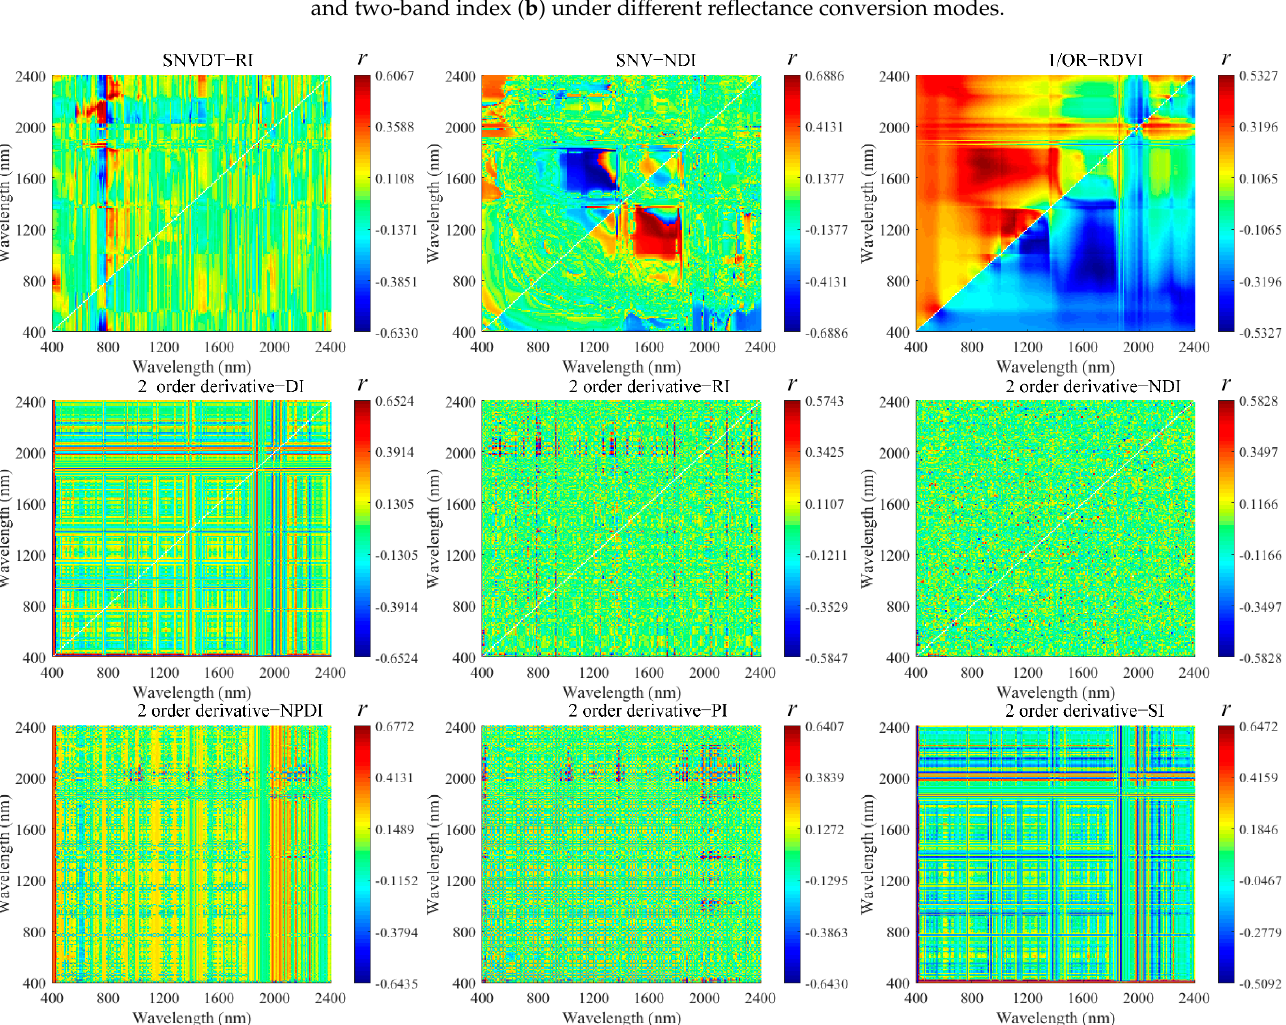
Figure 6. Two-dimensional correlation coefficients between EC and optimal spectral index under different transformation reflectance and two derivative orders (The x and y axis represent the wavelength 400~2400 nm, the right-side color bar indicates the color of the PCC values. The colors dark red and dark blue represent a relatively high PCC (red for positive and blue for negative) between the measured EC and the band